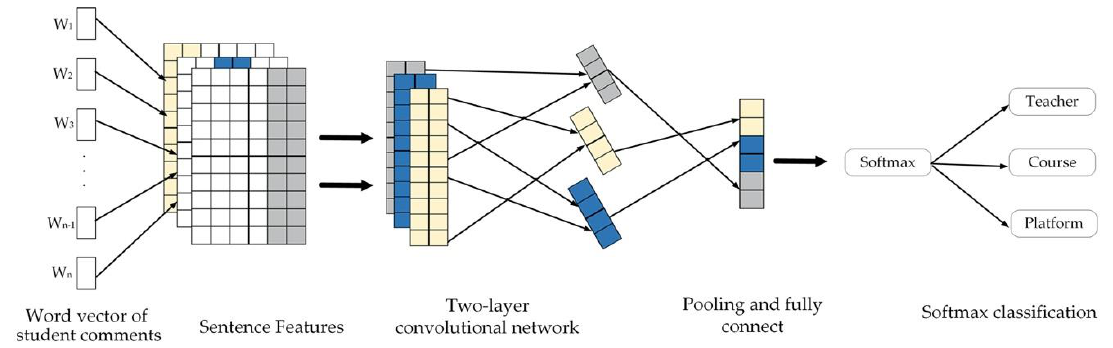
Figure 3. The aspect-oriented convolutional neural network ( A-CNN) model.